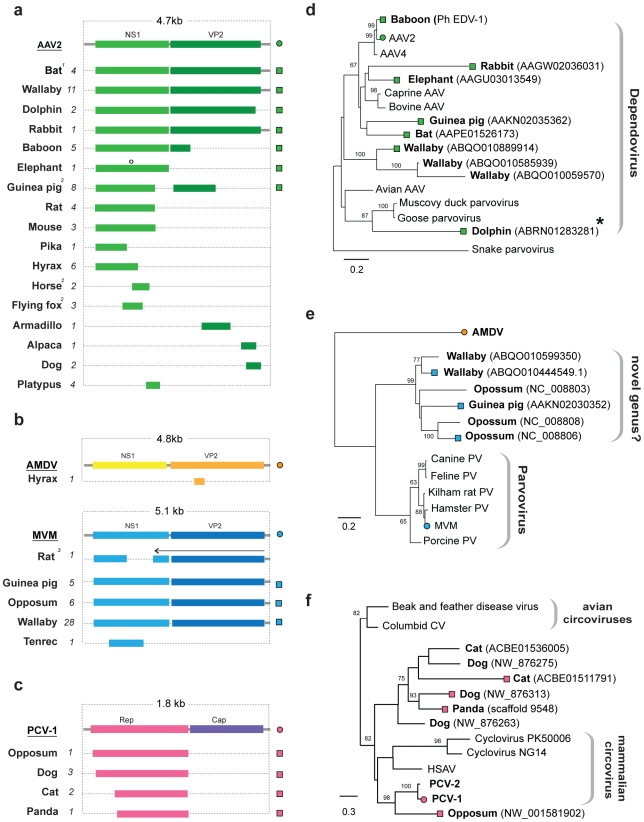
Genetic structures and phylogenetic relationships of EVEs related to ssDNA viruses.(a) Summary genetic structures of ssDNA EVE sets shown relative to the genus type species. The most intact elements are shown for each host taxon. EVE hosts (bold) and abbreviations for viral type species (bold, underline), and the total number of matches identified (italic) are indicated to the left of each EVE structure. Bars behind ORFs indicate non-coding viral DNA. Intact ORFs (circles) and expressed sequences (crosses) are indicated. 1 The M. lucifugus element is a composite of two genomic contigs; 2 Structures represent a composite of semi-overlapping fragments; 3 Element has undergone genomic rearrangements, with the arrow indicating the direction of the rearranged fragment. (b) Phylogenetic relationships of dependovirus EVEs and representative exogenous viruses, based on NS1 gene and rooted on snake parvovirus. A dolphin EVE (indicated by an asterisk) groups robustly with avian rather than mammalian isolates. (d) Phylogenetic relationships of parvovirus EVEs and representative exogenous viruses, based on NS1 gene and rooted on Aleutian mink disease virus. Support for both ML phylogenetic trees was evaluated using 1,000 nonparametric bootstrap replicates. EVEs potentially comprising a new genus are indicated. (d) Phylogenetic relationships of circovirus EVEs and representative exogenous viruses, based on the Rep gene and rooted on avian circoviruses, with support for the ML phylogenetic tree evaluated using 1,000 nonparametric bootstrap replicates. Taxa that are shown as genetic structures in (a) are indicated by colored squares (EVEs) and circles (exogenous viruses) (a). Abbreviations: AAV = adeno-associated virus; MMV = minute virus of mice, AMDV = Aleutian mink disease virus, PV = parvovirus, CV = circovirus, PCV = porcine circovirus; HSAV =  Human stool-associated circular virus.